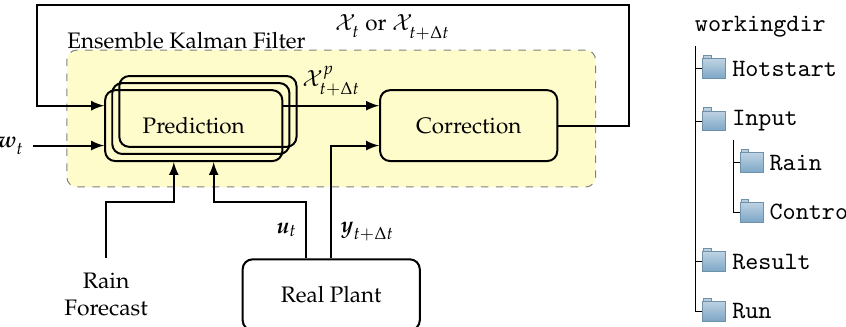
Figure 6. Schematic overview of data assimilation procedure ( left ) and the general folder structure of the early warning system tool ( right